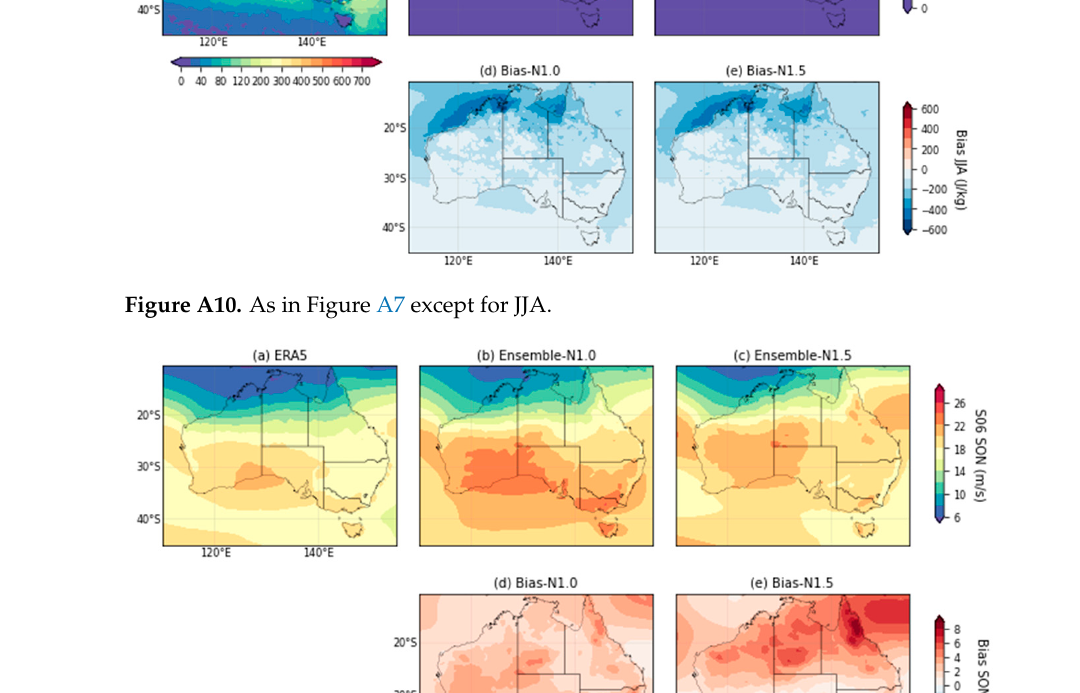
Figure A11. Climatology of S06 in d01 from ( a ) ERA5, ( b ) N1.0 and ( c ) N1.5 during SON. ( d , e ) are the biases of N1.0 and N1.5 from ERA5, respectively. Unit: m s − 1 .